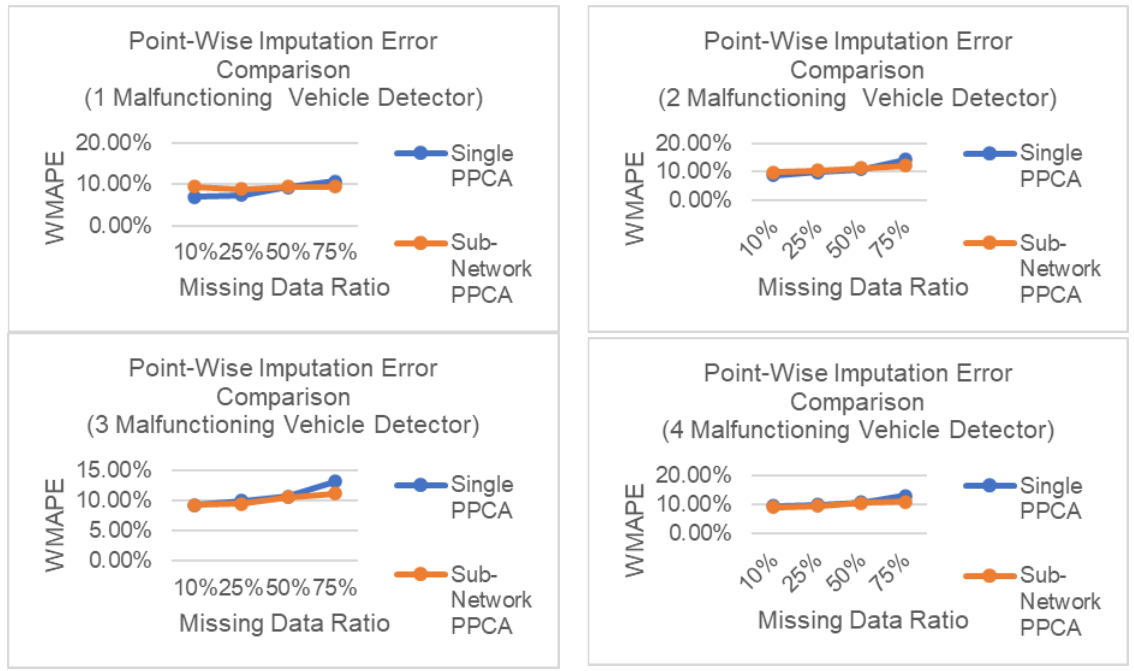
Figure 9. Scenario B Imputation error comparison for point-wise missing data.